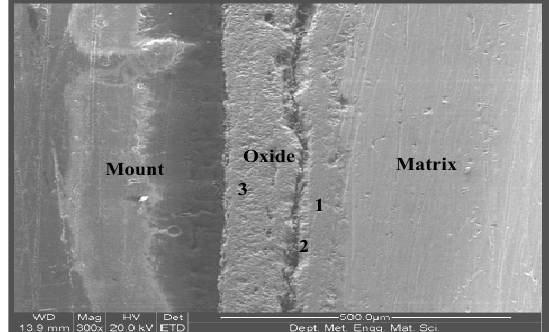
Figure 12. SEM/EDAX micrograph of the cross section of P92 alloy oxidized at 1073